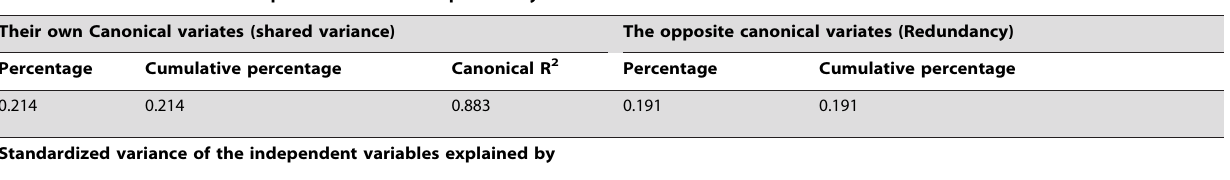
Standardized variance of the dependent variables explained by Their own Canonical variates (shared variance) The opposite canonical variates (Redundancy)